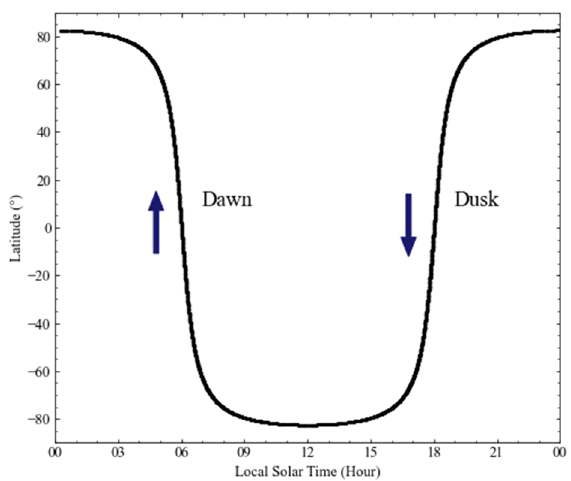
Figure 2. Local solar time versus latitude coverage of the QQ-Satellite orbit.